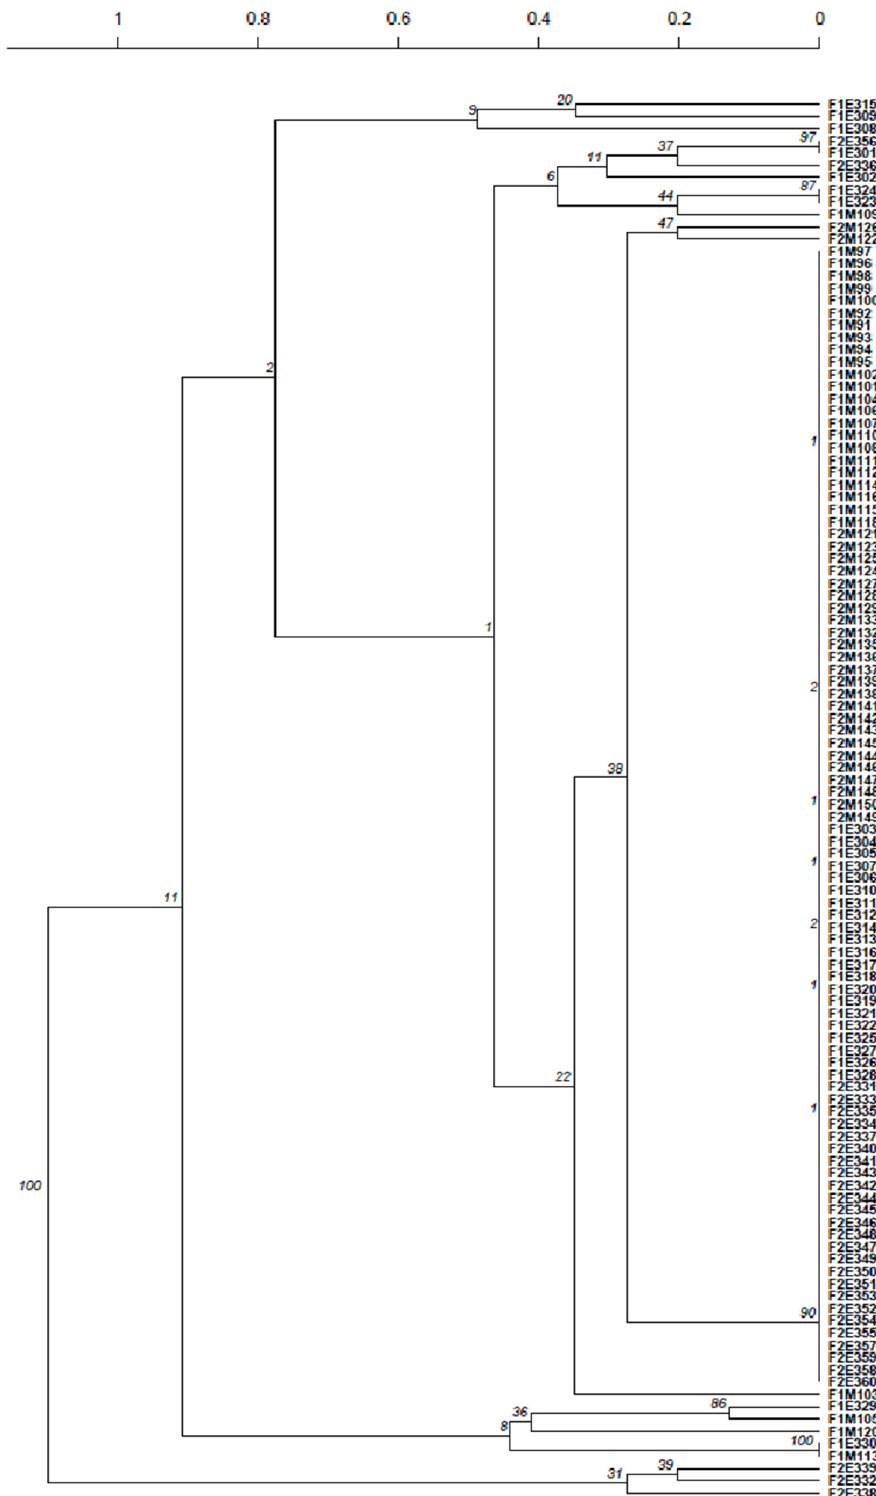
Figure 6. Dendrogram presenting the genetic distance between the isolates from the fermentation activator modality based on microsatellite profiles. Isolates from fermentation are represented by F1 or F2, depending on the fermentation activator used, followed by the letter M—middle or E—end of fermentation, and finally the number of the isolate. Scale at top represents genetic distance.